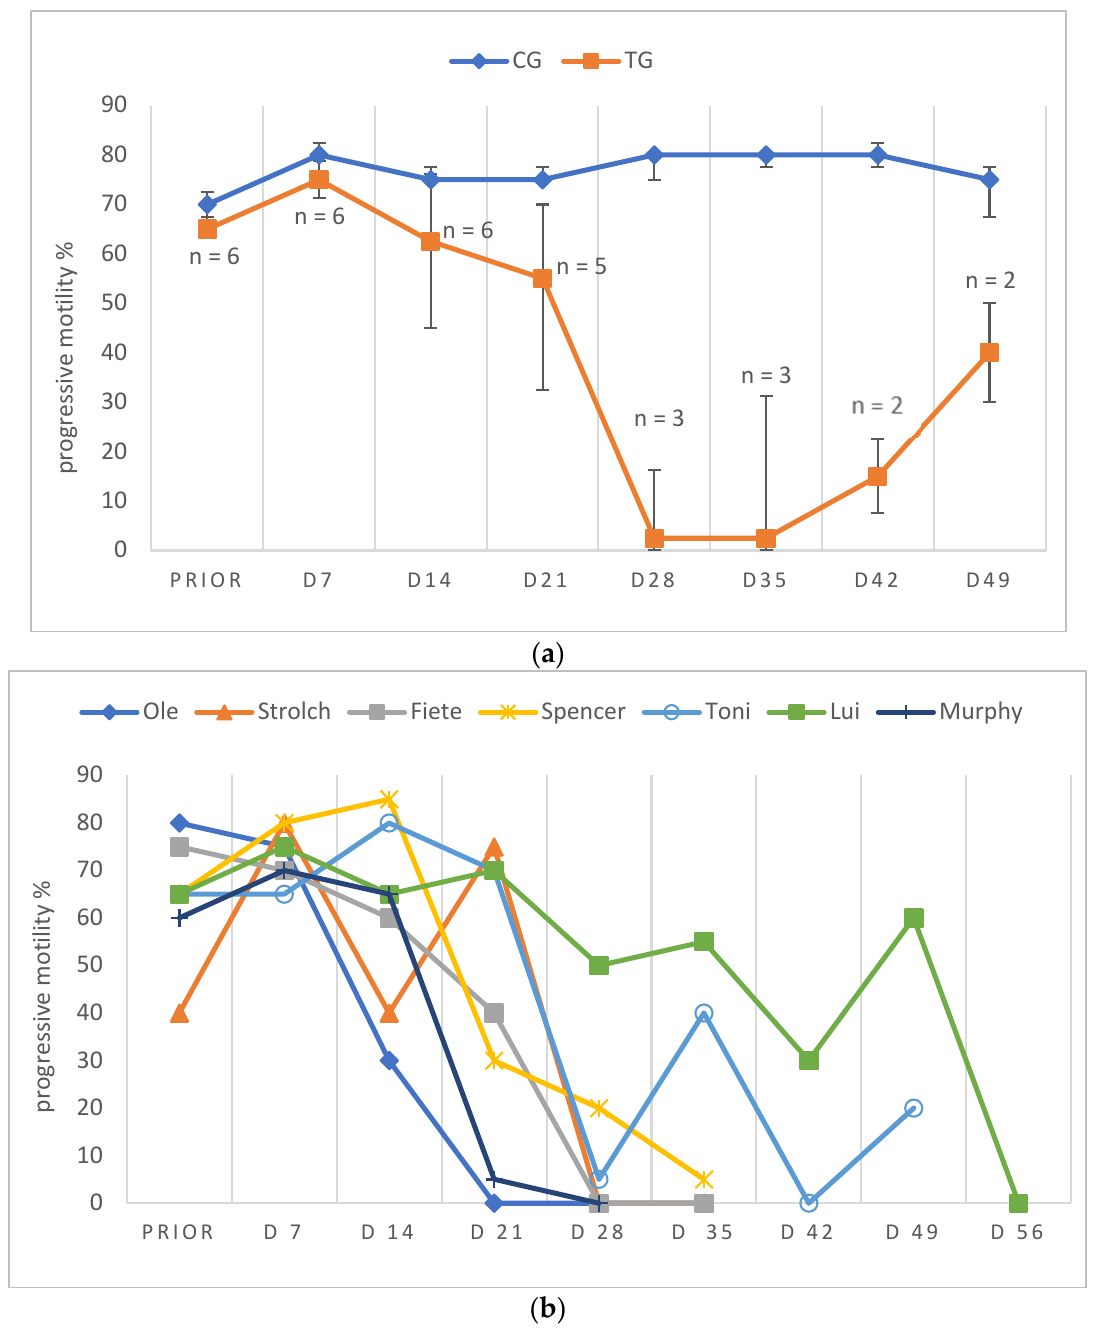
Figure 5. ( a ) Percentage of progressive motility given as median (Q1, Q3) over time of animals treated with a 4.7 mg deslorelin implant (TG, n = 6, if not indicated otherwise) and saline-treated control animals (CG, n = 3). “Prior” indicates “prior to treatment”. ( b ) Percentage of progressive motility of spermatozoa given as individual courses of animals treated with a 4.7 mg deslorelin implant (TG, n = 7) over time. “Prior” indicates “prior to treatment”.